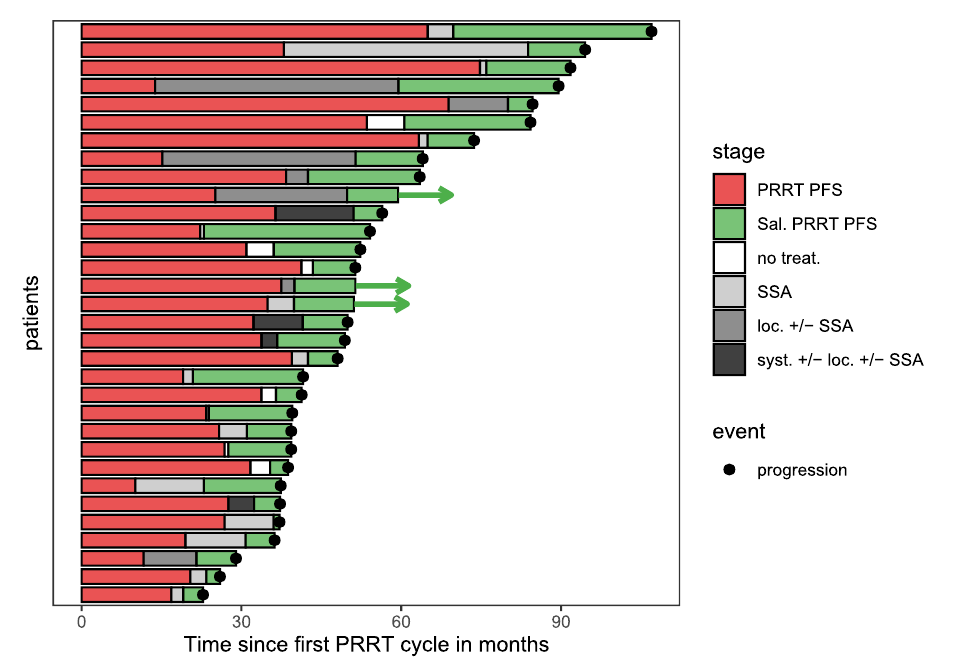
Figure 1. Swimmer plot illustrating clinical course of study patients. The red bars represent the PFS after initial PRRT, the green bars the PFS after salvage PRRT. The time between progression after the initial PRRT and the start of salvage PRRT is illustrated by bars with grayscale colors indicating the intensity of additional therapies in this period (white: no treatment; light grey: somatostatin analogues; dark grey: local therapies ± somatostatin analogues; black: systemic treatments other than somatostatin analogues (chemotherapy, tyrosine kinase inhibitors, mTOR inhibitors) ± local therapies ± somatostatin analogues). Arrows indicate censored patients regarding PFS. Progression after salvage PRRT was observed in 29 of 32 patients (91%; progression according to RECIST 1.1, 25; death from any cause, 3; start of a new treatment due to pro- gression of cancer-related symptoms, 1). The median PFS after salvage PRRT was 10.8 months (95% confidence interval (CI): 8.0 – 15.9 months) as illustrated by the Kaplan – Meier curve in Figure 2. The median follow-up time in patients without progression was 11 (range: 10 – 11) months.